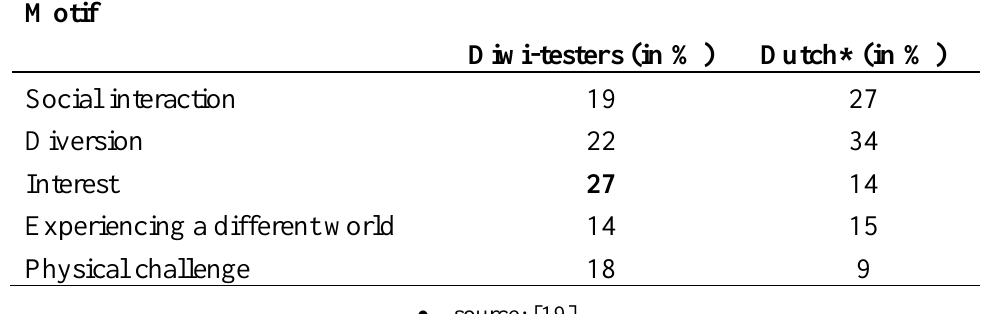
Table 2. Recreational motives of theDiwi testers (%) compared to average Dutch